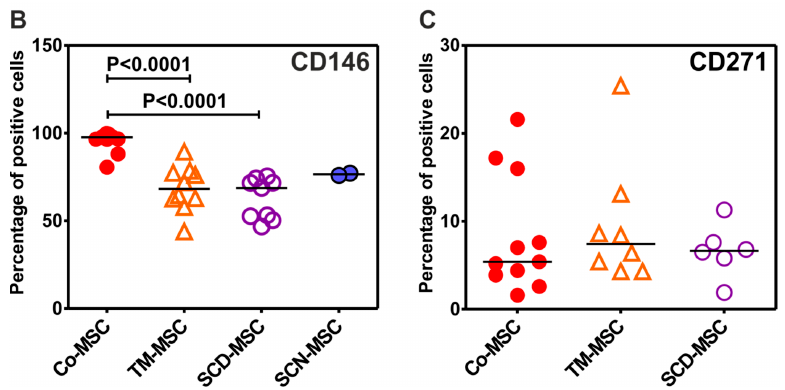
Figure 3. The phenotype and differences in the expression of CD146 and CD271 antigens on MSCs of patients with NMHD. ( A ) Phenotype of passage 2 MSCs in a patient with TM. MSCs were immunostained with fluorochrome-conjugated monoclonal antibodies and incubated at 4 °C for 30 min. After two wash steps with PBS + 0.2% BSA the stained cells were analyzed on a FACSCalibur (Becton-Dickinson, Heidelberg) equipped with Macintosh software for data analysis (CellQuest). At least 50.000 events were acquired for each measurement. ( B ) Expression of CD146 antigen on MSCs of passage 2 in patients with TM (68.2% (43.8–89.3), N = 10) and SCD (68.7% (46.7–75.4) N = 9)) was significantly lower than in MSCs of healthy controls (97.65% (80.6–99.8), N = 12, P < 0.0001). ( C ) Passage 2 MSCs of patients with non-malignant hematological diseases expressed similar levels of CD271 antigen as MSCs of healthy donors. Co: Control, TM: thalassemia major, SCD: sickle cell disease, SCN: severe congenital neutropenia.